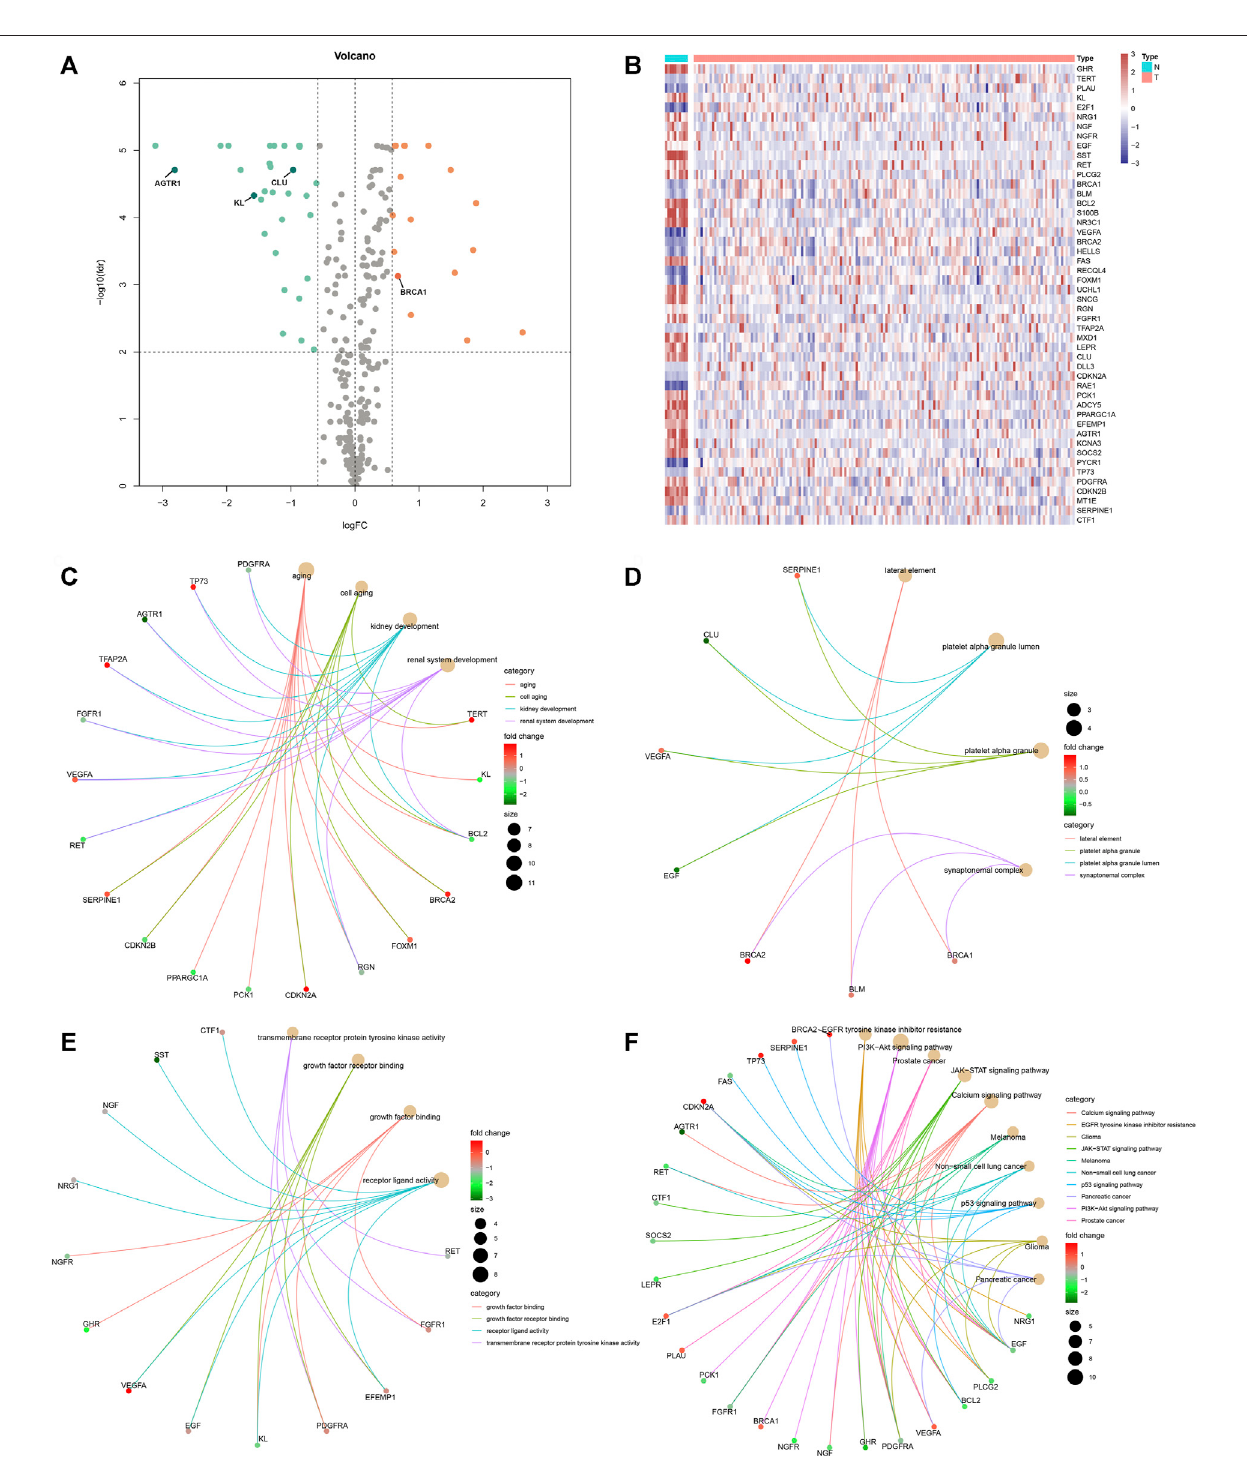
FIGURE1| Expressionpatternandbiologicalfunctionofaging-relatedgenesinrectalcancer.Differentiallyexpressedaging-relatedgeneswereidenti fi edbetween rectal cancer and normal specimens in the TCGA cohort with the cutoff values of |FC| > 1.5 and FDR < 0.01. (A, B) Volcano and heat map visualized upregulated and downregulated aging-related genes in rectal cancer (T) than normal (N) specimens. Red means upregulated genes, blue means downregulated genes, and gray means nonsigni fi cant genes. (C – E) Biological processes, molecular functions, and cellular components of dysregulated aging-related genes. (F) KEGG pathways enriched by dysregulated aging-related